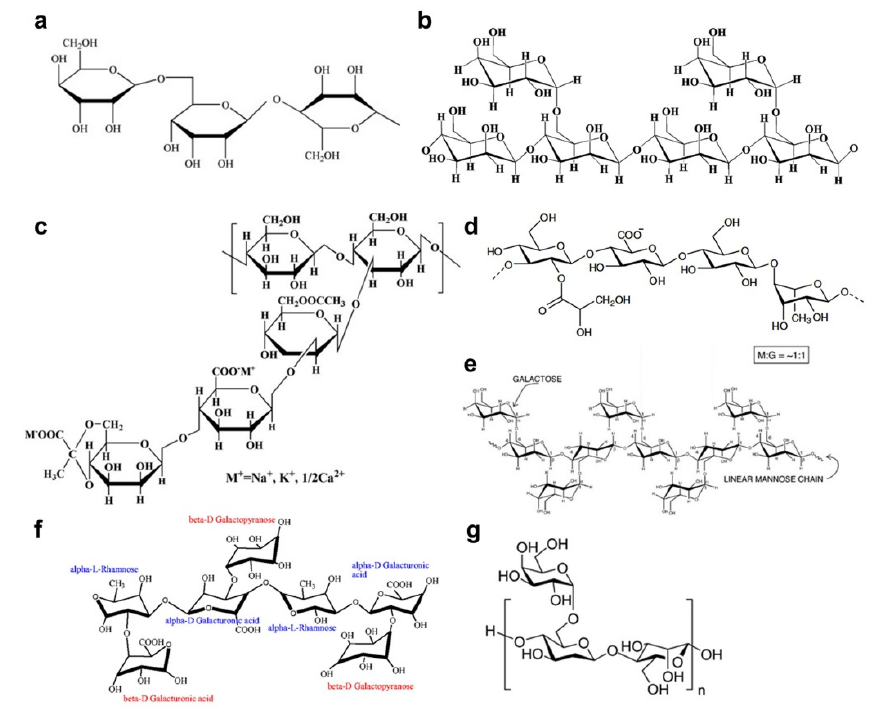
Figure 1. Chemical structures of ( a ) GA [25], ( b ) GG [26], ( c ) XG [26], ( d ) GEG [27], ( e ) FG [28], ( f ) KG [29], and ( g ) AG [30].